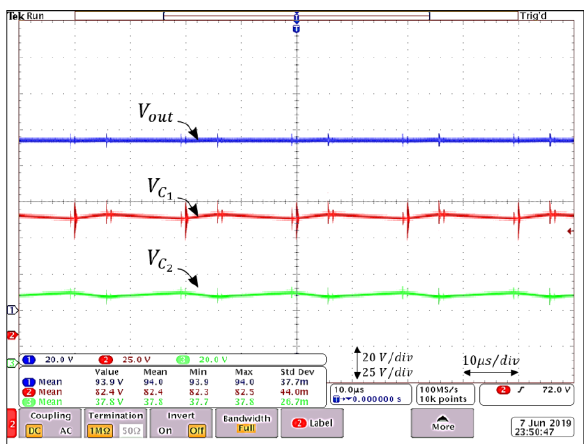
Figure 13. Graphic of voltages across capacitors and the output under the proposed input current control and ripple cancellation with I in = 8A as set-point.